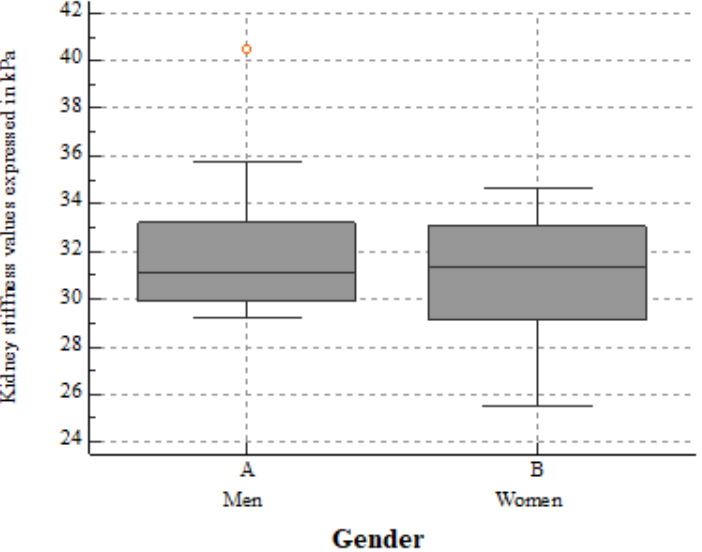
Figure 2. The mean kidney stiffness values in healthy men and women. No significant differences between 2D-SWE PLUS mean values were found ( p = 0.2185).